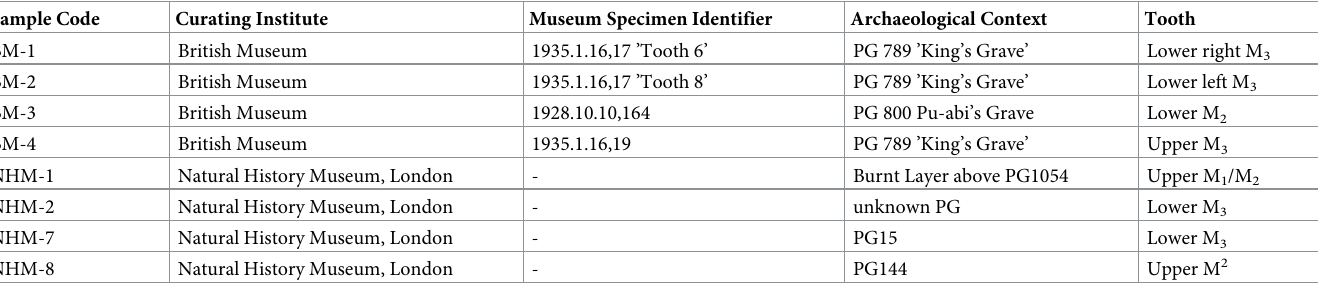
Table 1. Summary of Bos taurus teeth selected for sequential enamel δ 18 O, δ 13 C and 87 Sr/ 86 Sr analysis. Sample